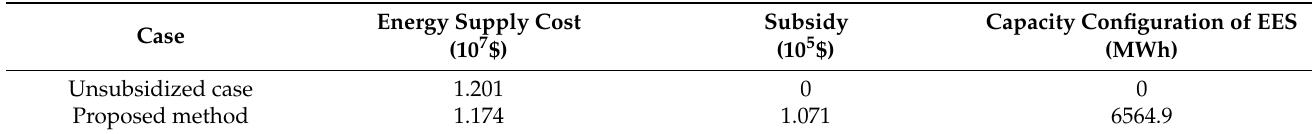
Table 6. The Comparisons of Energy Supply Cost, Subsidy, and Capacity Configuration.